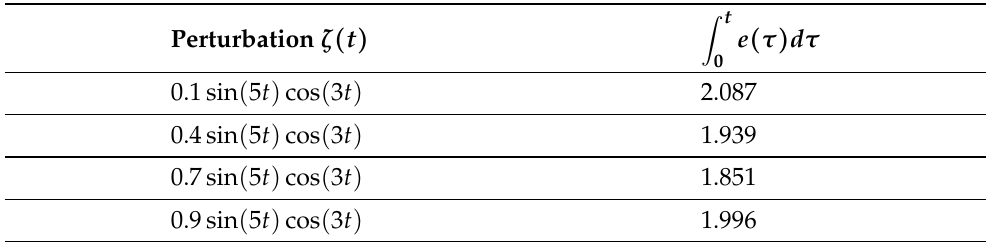
Table 1. Controller behavior against different perturbation